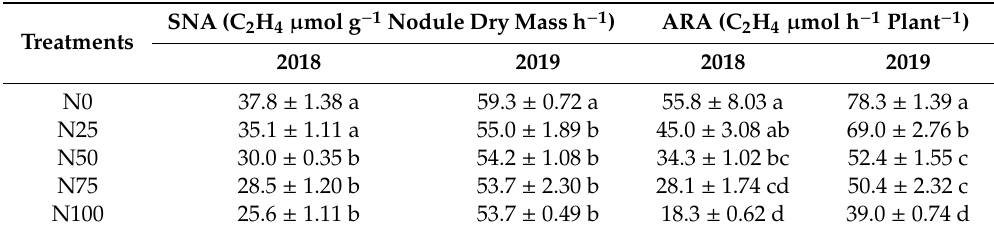
Table 2. Change in acetylene reduction activity (ARA) and specific nitrogenase activity (SNA) of long-term experiment I.